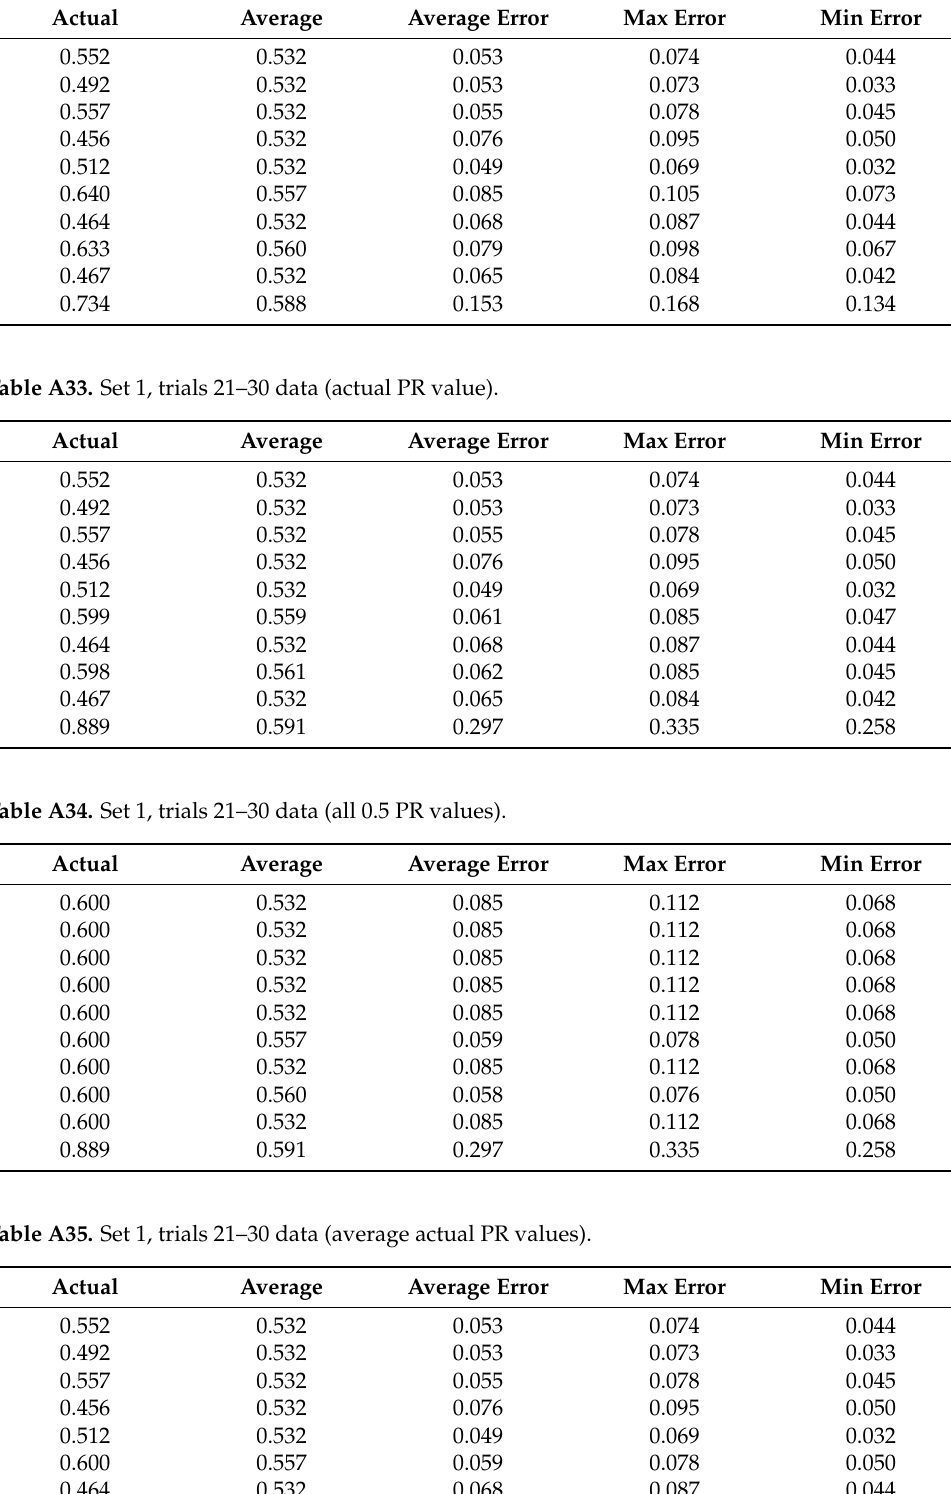
Table A32. Set 1, trials 21–30 data (single 0.5 PR value).